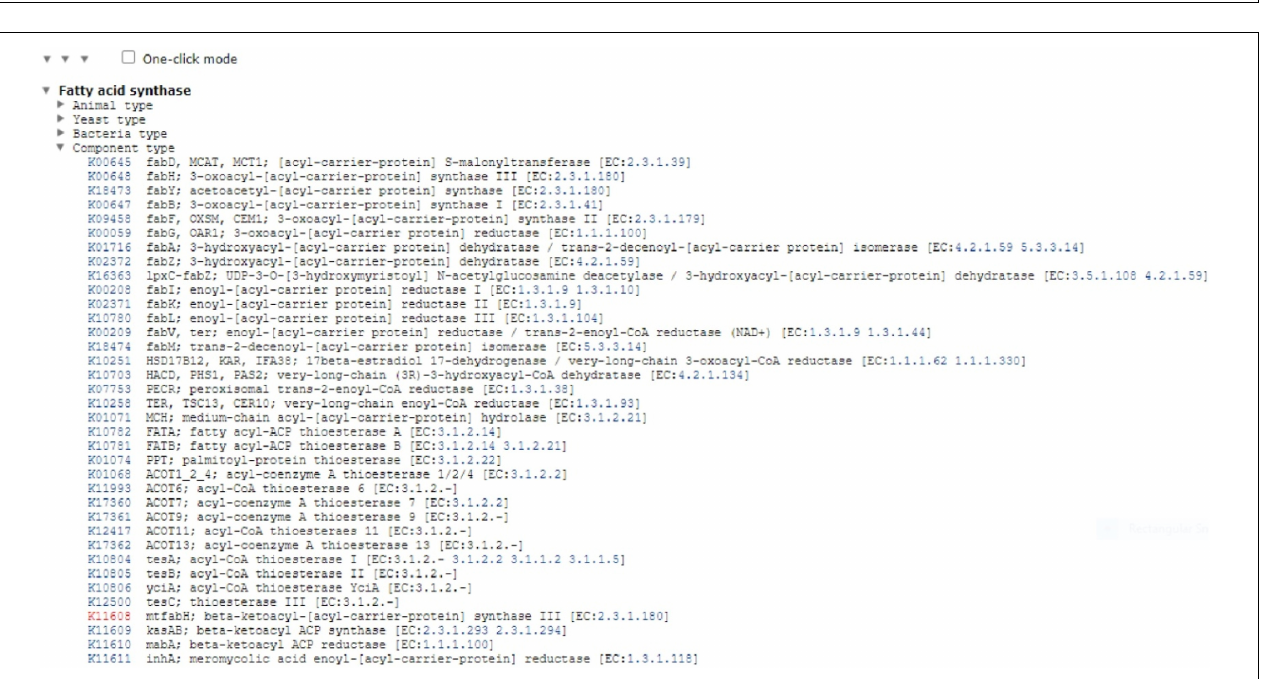
FIGURE 1 | Global metabolic pathways of fatty acid (FA) biosynthesis using KEGG Mapper. The Mycobacterium bacterial metabolic pathways are colored, and the fatty acid (FA) pathways are in red indicated with arrow.